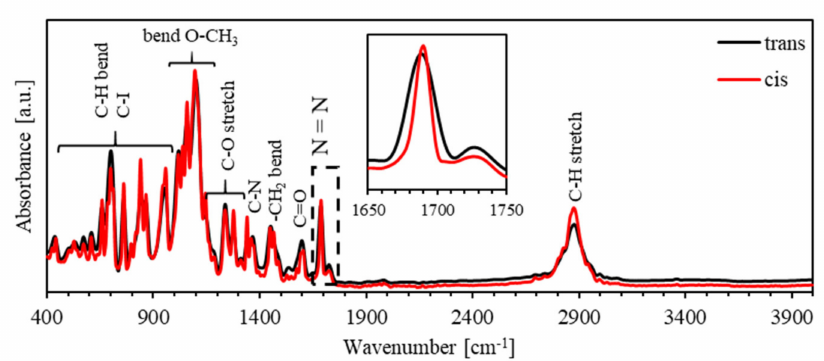
Figure 11. The FTIR spectra of trans - and cis -phases of (PEO-BDK-MR)/I 2 (10%) complex composite thin